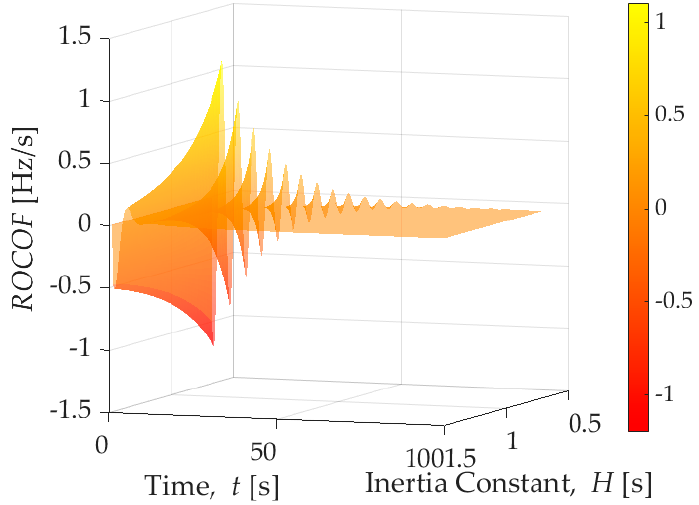
Figure 5. Rate-of-Change-of-Frequency ( ROFOF in Hertz/s) in a single area power system, considering changes in the inertia H ∈ [0.5, 1.5] s.